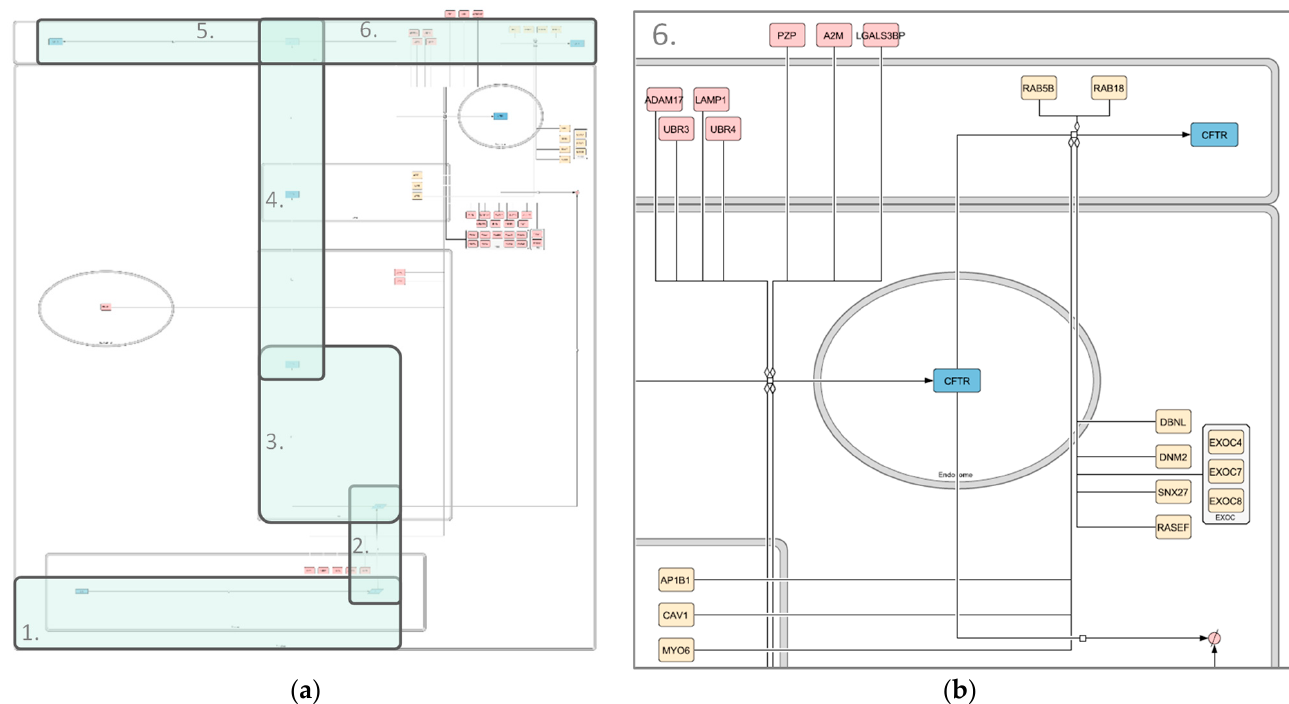
Figure 4. Image of the high-throughput CFTR Endocytosis, Recycling and Degradation map. ( a ) Whole map; ( b ) zoomed-in section of the map. Compartments are depicted in grey, CFTR in blue and interactors in shades of red (degradation associated) and yellow (recycling associated). State transitions and modulations are shown in black. Different shapes represent different kinds of interactors. Rounded rectangles correspond to proteins, rectangles correspond to genes and rhomboids to RNA molecules. The map was created using libsbgnpy 0.2.2 and CellDesigner4.4.2. Table 2. Description of the five submaps of the CFTR high-throughput model.